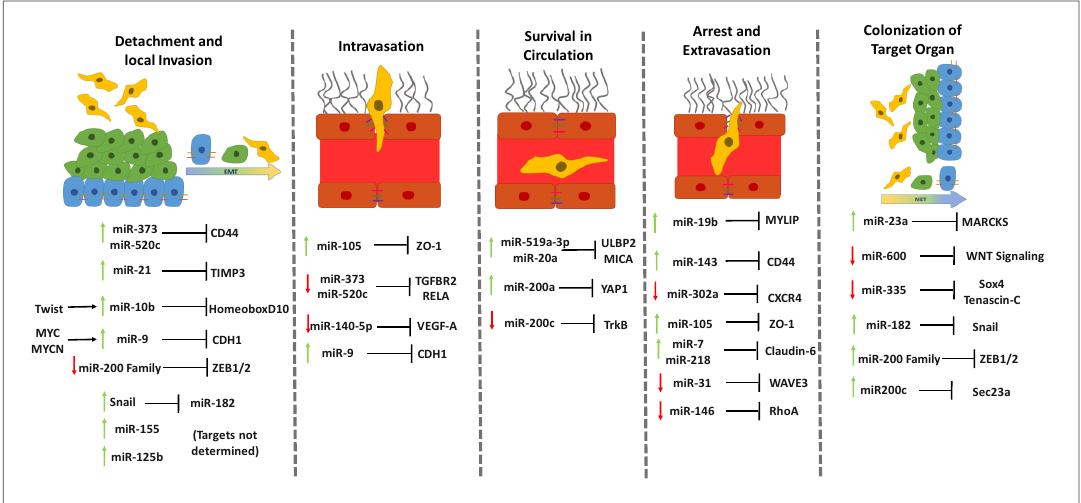
Figure 1. Simplified representation of the metastatic cascade of breast cancer and of the microRNAs (miRNAs; miR) involved in each of the steps of the process. This multistep process comprises: (1) detachment and local infiltration of malignant cells into the surrounding tissue, which involves phenotypic changes with loss of epithelial features such as the adhesion of neighboring cells and gain of mesenchymal features that endow cells with migratory properties, a process known as epithelial-mesenchymal transition; (2) intravasion, corresponding to the transendothelial migration of breast cancer cells to reach the circulation; (3) circulation and survival in the blood stream; (4) arrest and extravasation into the target organ, involving the transendothelial migration across the endothelium; and (5) proliferation and colonization of competent organs, involving the gain of the epithelial characteristics and loss of the mesenchymal ones, a process known as mesenchymal-epithelial transition. The miRNAs that have been associated with each of the steps of the metastatic cascade are represented. Those working as oncogenes are usually upregulated (green arrows), while the ones that work as tumor suppressors are usually downregulated (red arrows). Known downstream targets and upstream regulators of miRNAs are also